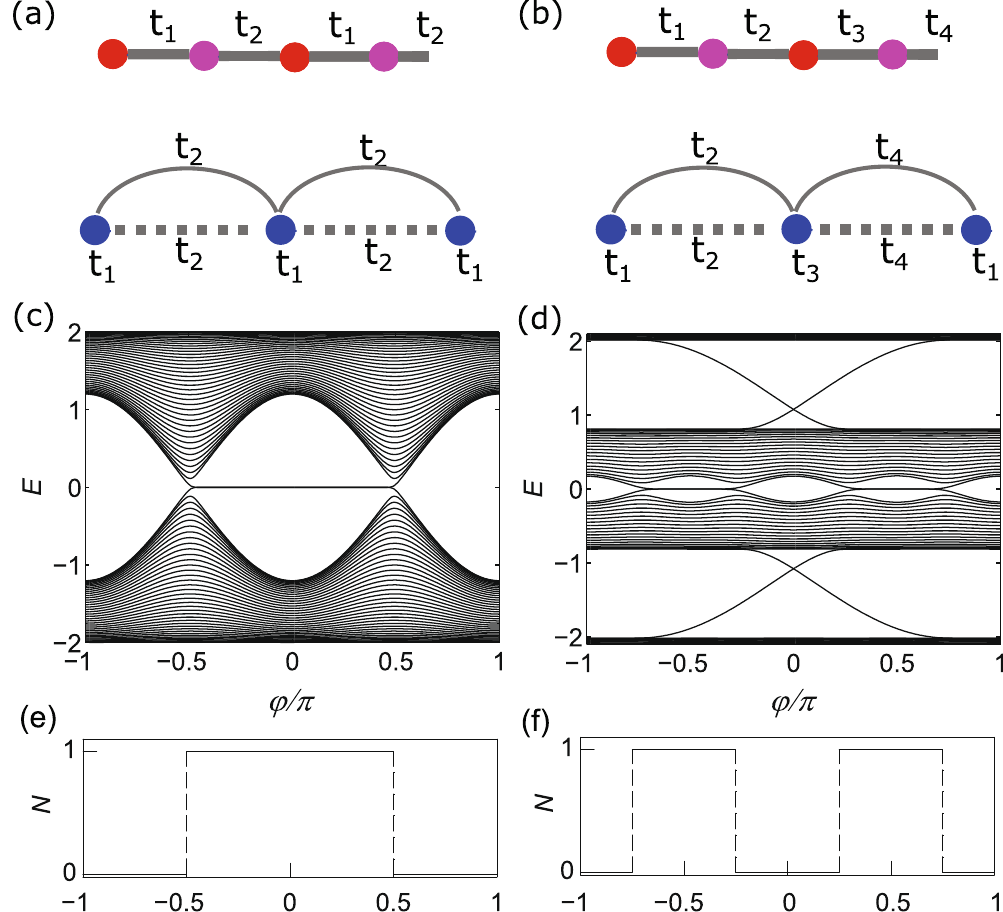
Figure 1. Schematic illustration of the model Eq. (1) (upper) with the period: ( a ) T = 2; ( b ) T = 4. The red (pink) circles represent Majorana fermions α ( β ). The lower ones schematically illustrate the corresponding models in terms of fermions (blue circles). The energy spectrum on an open chain as a function of ϕ : ( c ) T = 2; ( d ) T = 4. The winding number as a function of ϕ : ( e ) T = 2; ( f ) T = 4. The parameter λ = 0.6 is